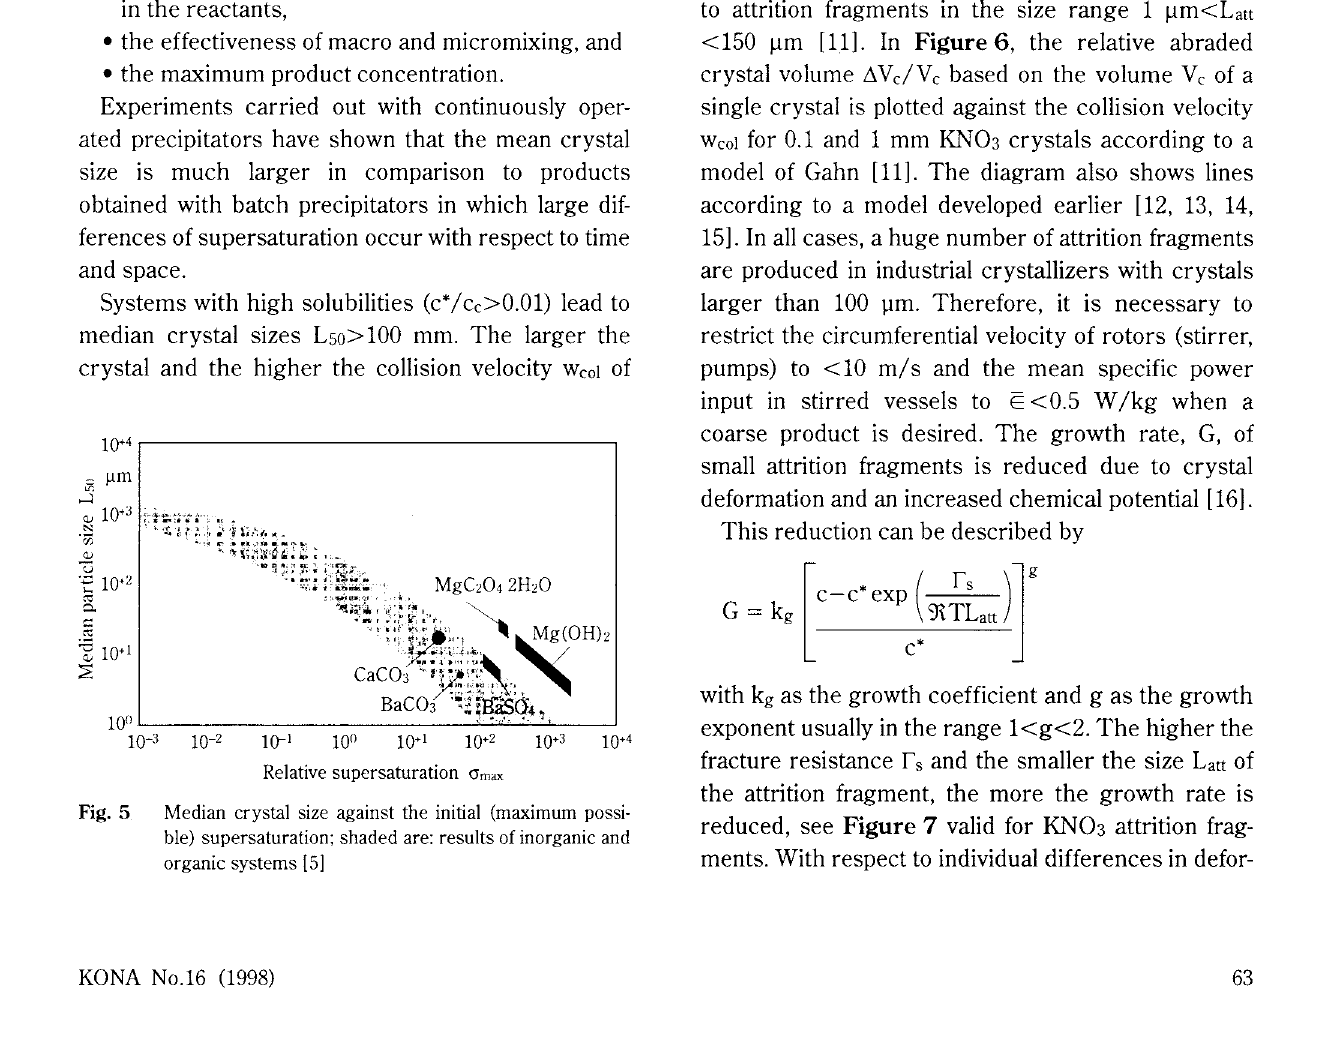
Fig. 5 Median crystal size against the initial (maximum possi ble) supersaturation; shaded are: results of inorganic and organic systems [ 5]